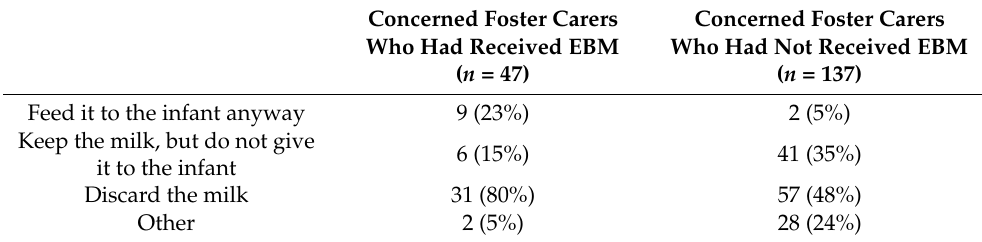
Table 2. Foster carers’ actual or planned response to concerns about the safety of expressed breastmilk (EBM)